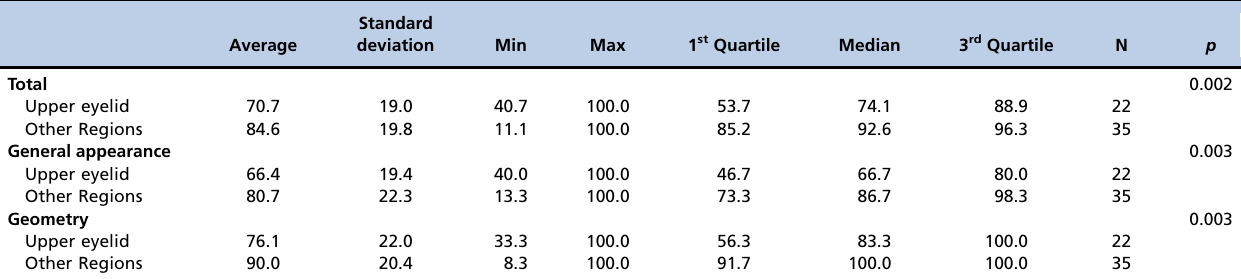
Table 4 - Summary measures of facial satisfaction factors by procedure location - upper